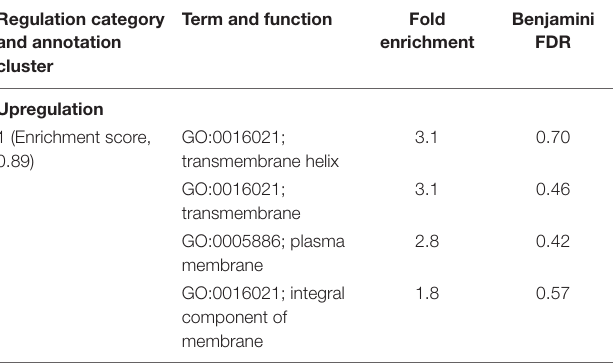
The genes categorized in upregulation group 1 are marked as yellow in Supplementary Table S4.